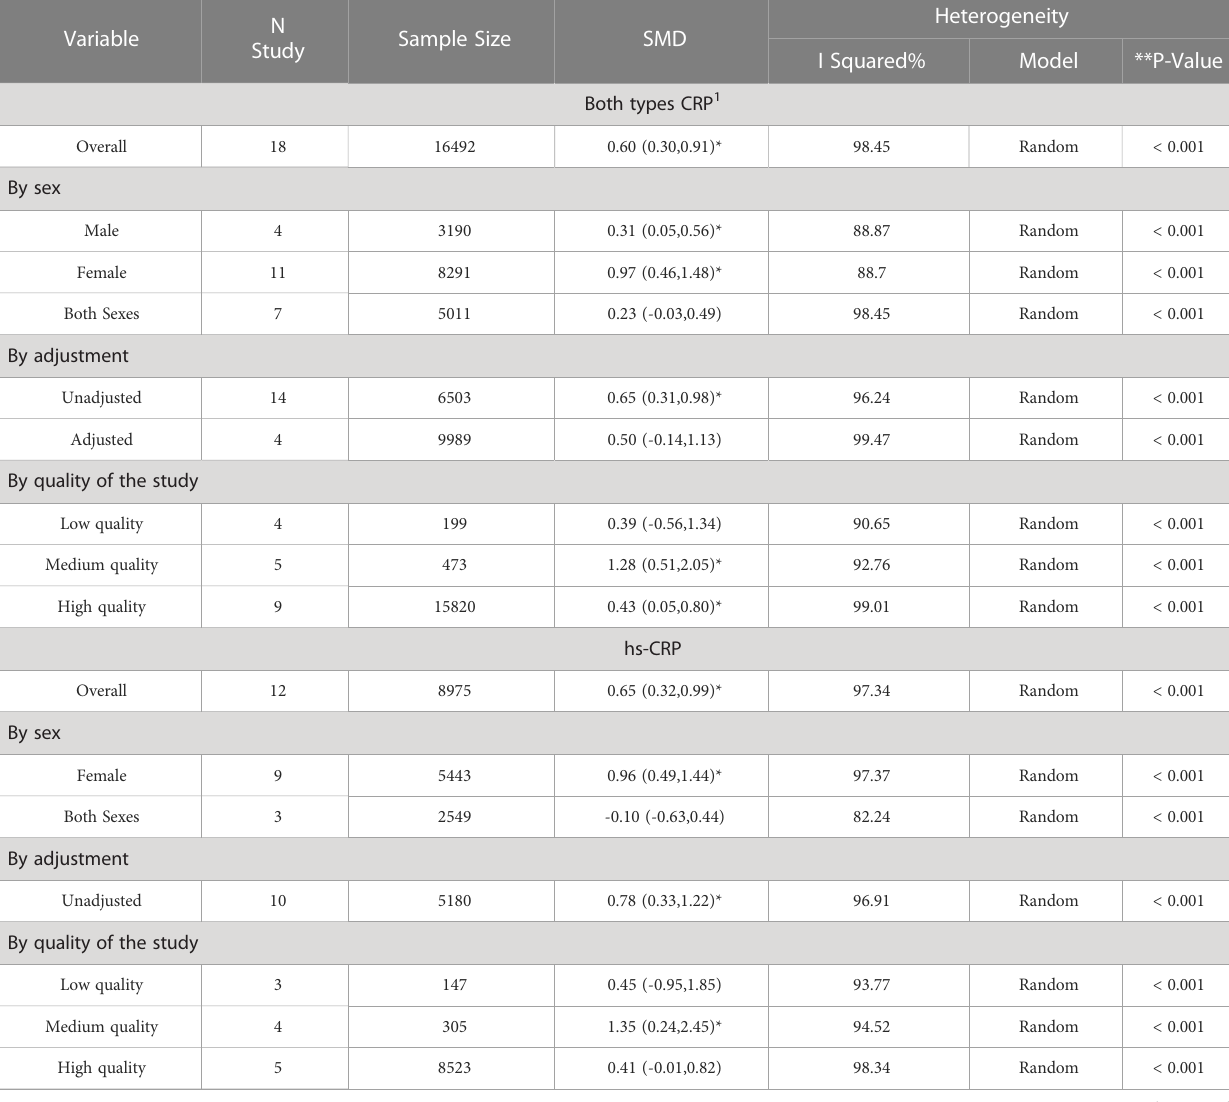
TABLE 3 The overall association between NWO, and the means of in fl ammatory